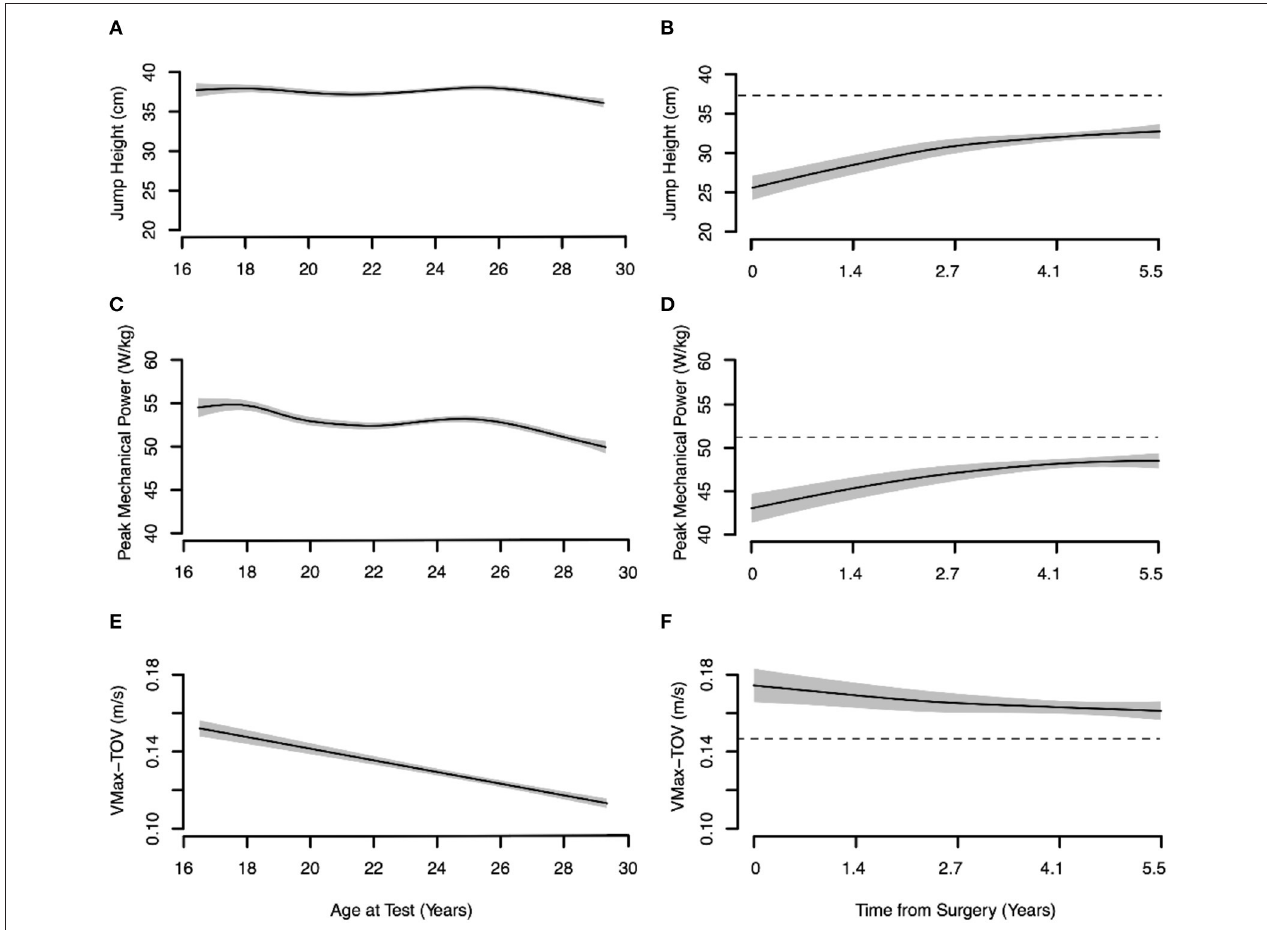
FIGURE 4 | Age-dependent changes in concentric phase jump measures for the non-injured controls and post-surgical time-dependent changes in anterior cruciate ligament reconstructed (ACLR). Dashed black lines show mean value for non-injured controls > 25 years of age. Solid black lines show the mean value for the typical athlete ± the 95% CI marked in gray shading. Vmax-TOV Difference– 1 maximum velocity of the body center of mass and takeoff velocity. (A) Jump height control. (B) Jump height ACLR. (C) Peak mechanical power control. (D) Peak mechanical power ACLR. (E) VMax-TOV difference control. (F) VMax-TOV difference